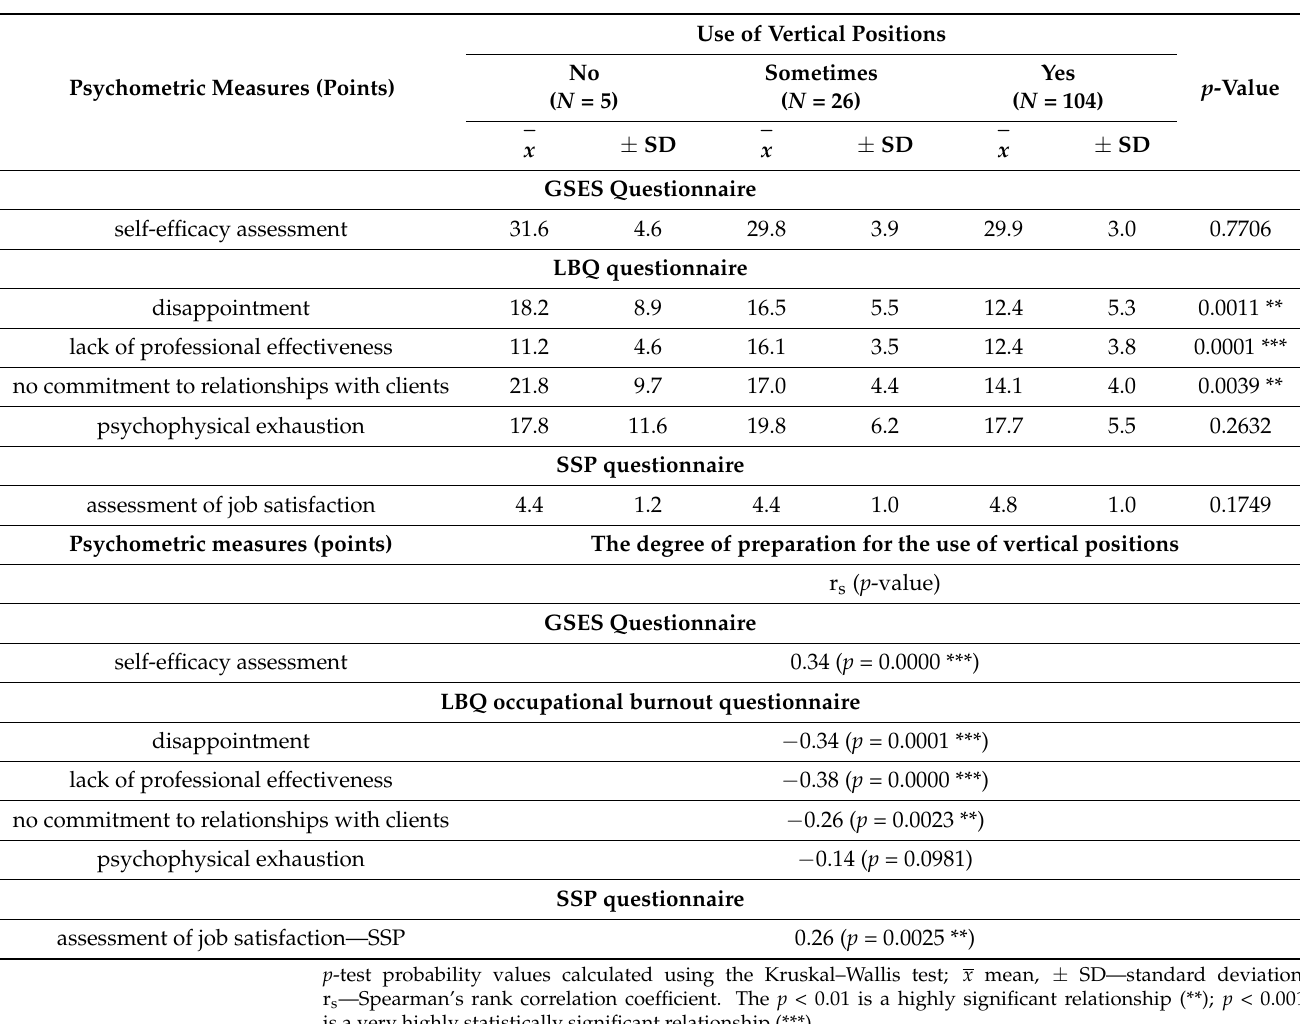
Table 5. Self-efficacy, job satisfaction, and the level of occupational burnout versus the use of vertical positions and the degree of preparation for the use of vertical